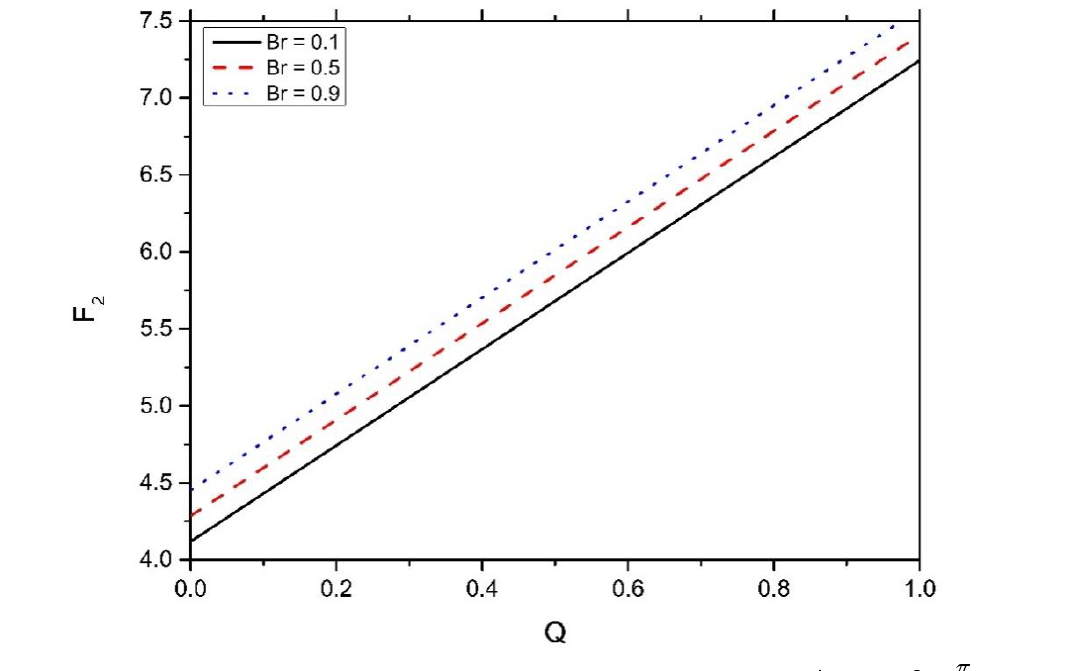
N = 0.5, N = 0.1,  = 0.1,  = b t  = 1